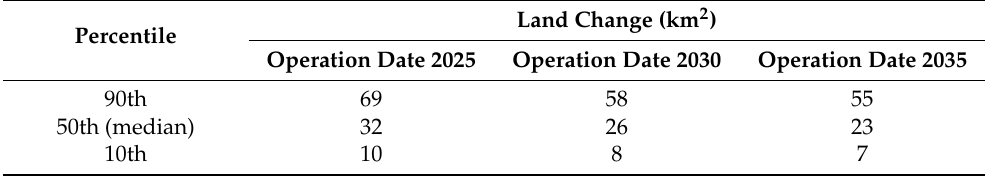
Table 2. Statistical summary of the net land change in km 2 by 2100 for the three operation dates.